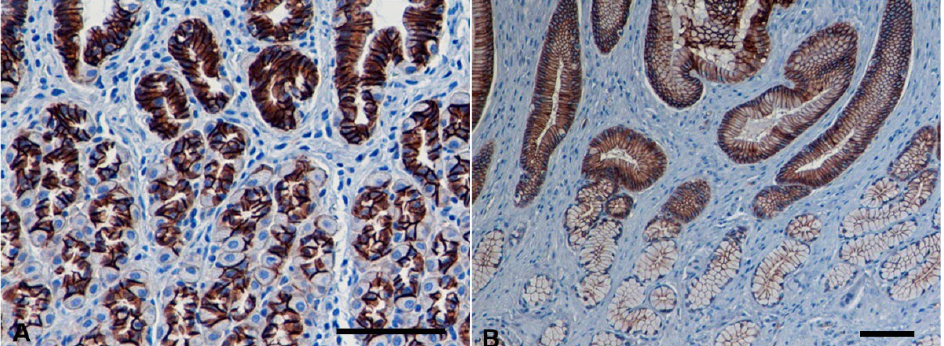
Figure 2. Normal canine gastric mucosa. Immunohistochemistry for E-cadherin (E-cad) counter- stained with Mayer’s hematoxylin. Strong membranous expression of E-cad, at the lateral cell to cell boundaries (polarized pattern) in superficial foveolar epithelium and deep gastric glands from gastric body ( A ) and pyloric antrum (bar = 100 µ m) ( B ). Note the decrease in labeling intensity in the antral glands (bar = 100 µ